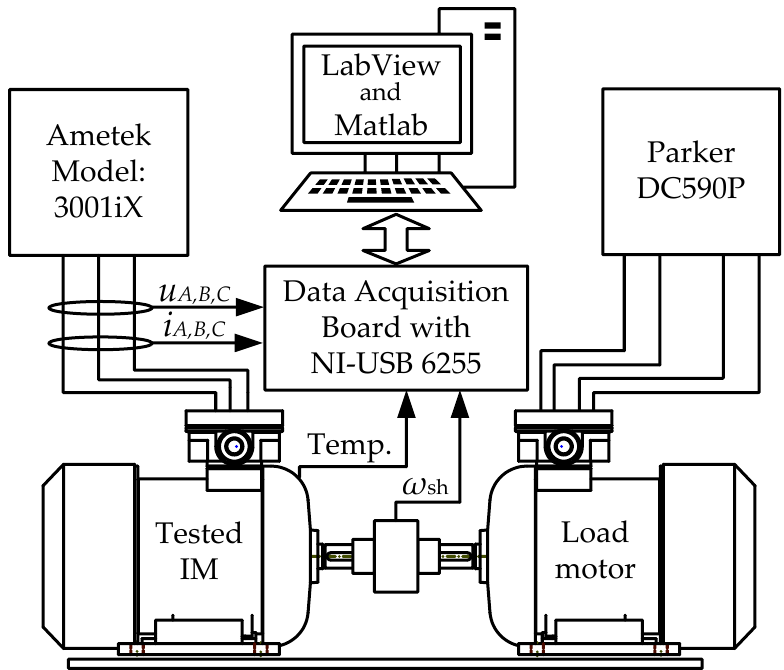
Figure A3. The schematic diagram of the laboratory test bench.